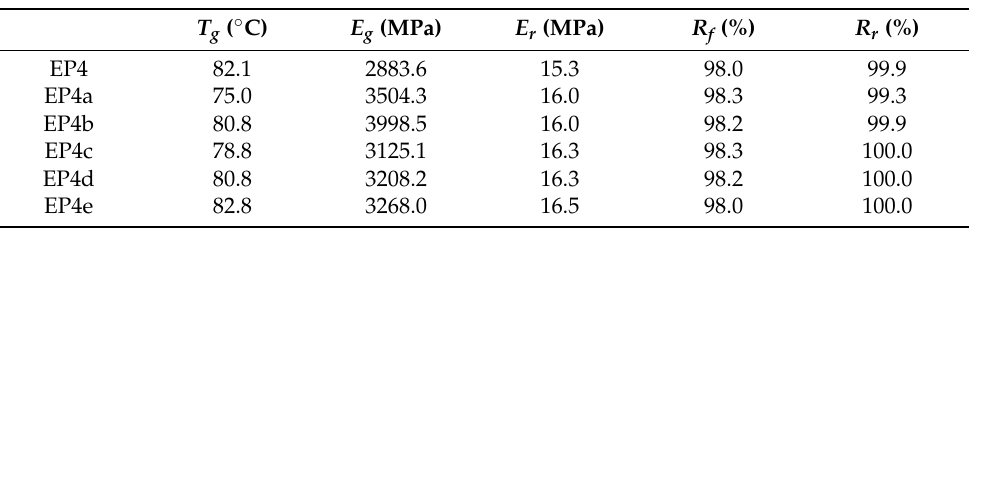
Table 4. Dynamic mechanical properties and recovery ability of